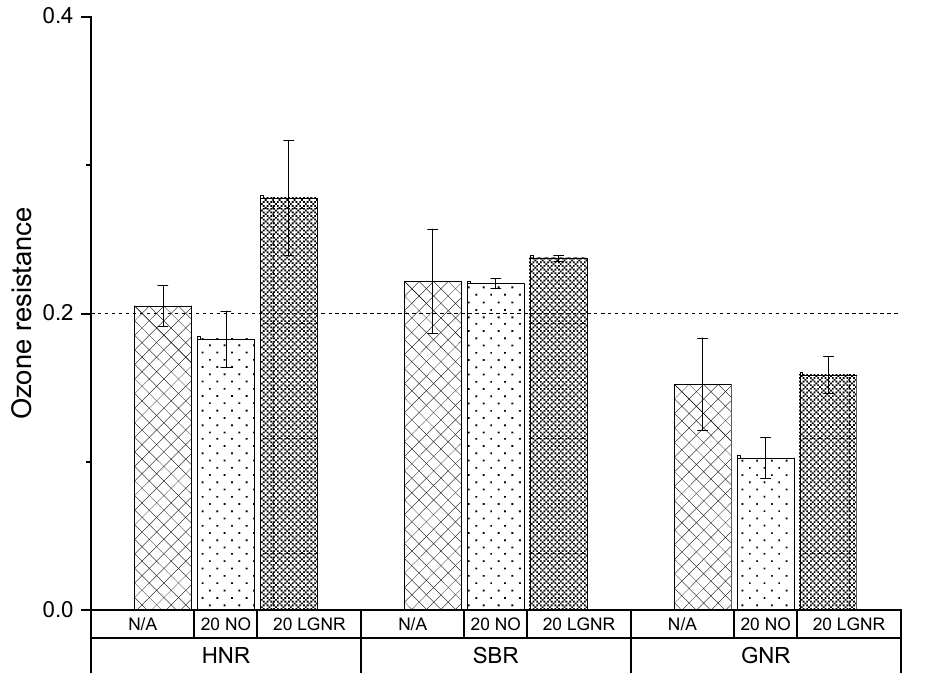
Figure 20. Ozone resistance of HNR, SBR and GNR composites made with or without processing aids. N/A: rubber compounds without processing aids; 20 NO: rubber compounds with 20 phr naphthenic oil; 20 LGNR: rubber compounds with 20 phr liquid guayule natural rubber.